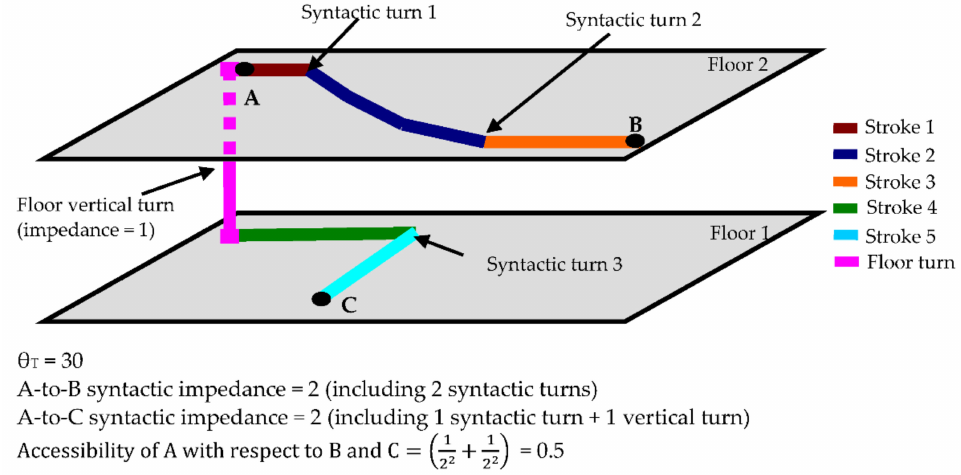
Figure 9. Syntactic impedance of traveling paths and accessibility estimation with α =